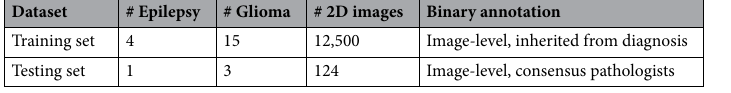
Table 1. Brain tissue datasets for deep